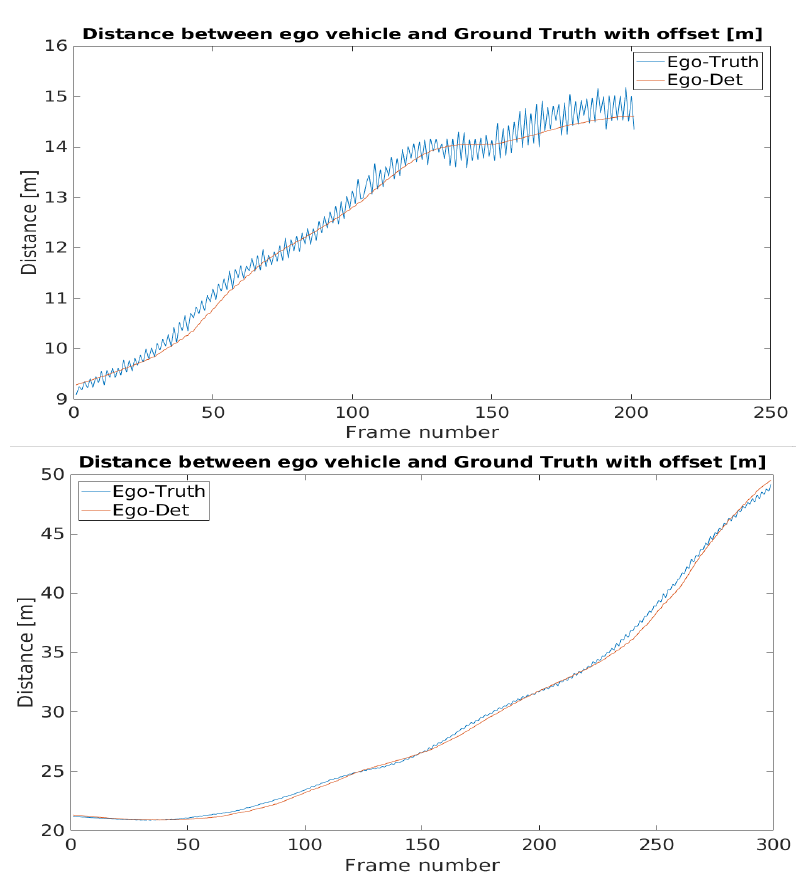
Figure 38. Distance of the detected and ground truth positions of the BMW ( above ) and the Truck ( below ) from the ego